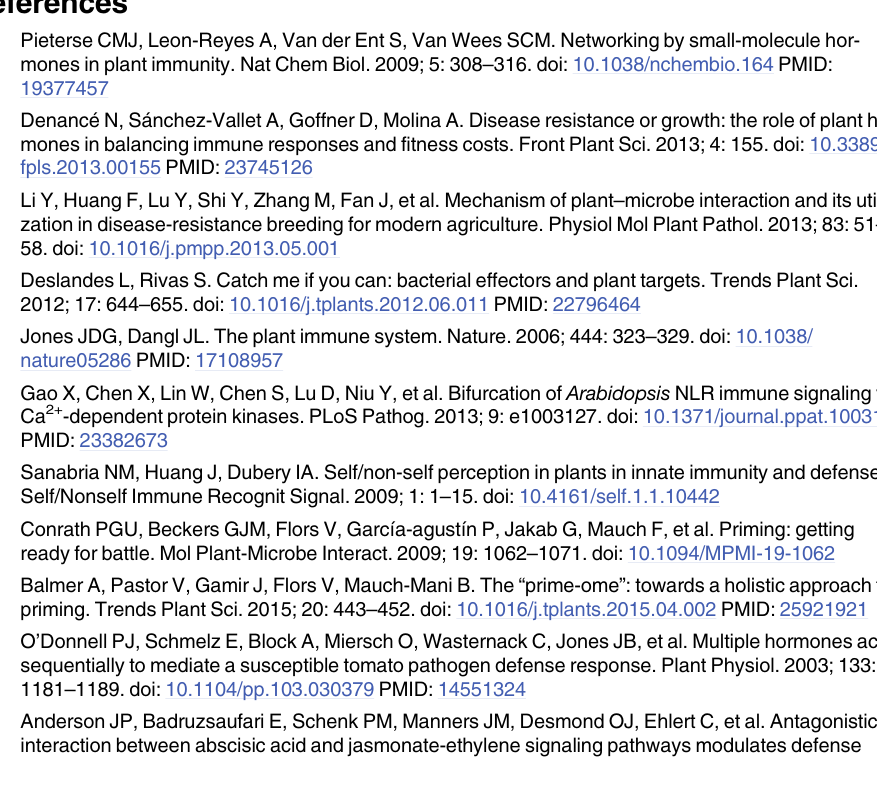
Fig. 5-Feruloylquinic acid. Extracted single ion chromatograms (XIC) of UHPLC-MS/MS data showing the retention times (A) and the corresponding MS fragmentation pattern (B). H Fig. Caffeoyl glucosyl quinic acids. MS spectra showing fragmentation patterns of 3-O-(4 ’ -O- caffeoyl glucosyl) quinic acid (A) and 5-O-(3 ’ -O-caffeoyl glucosyl) quinic acid